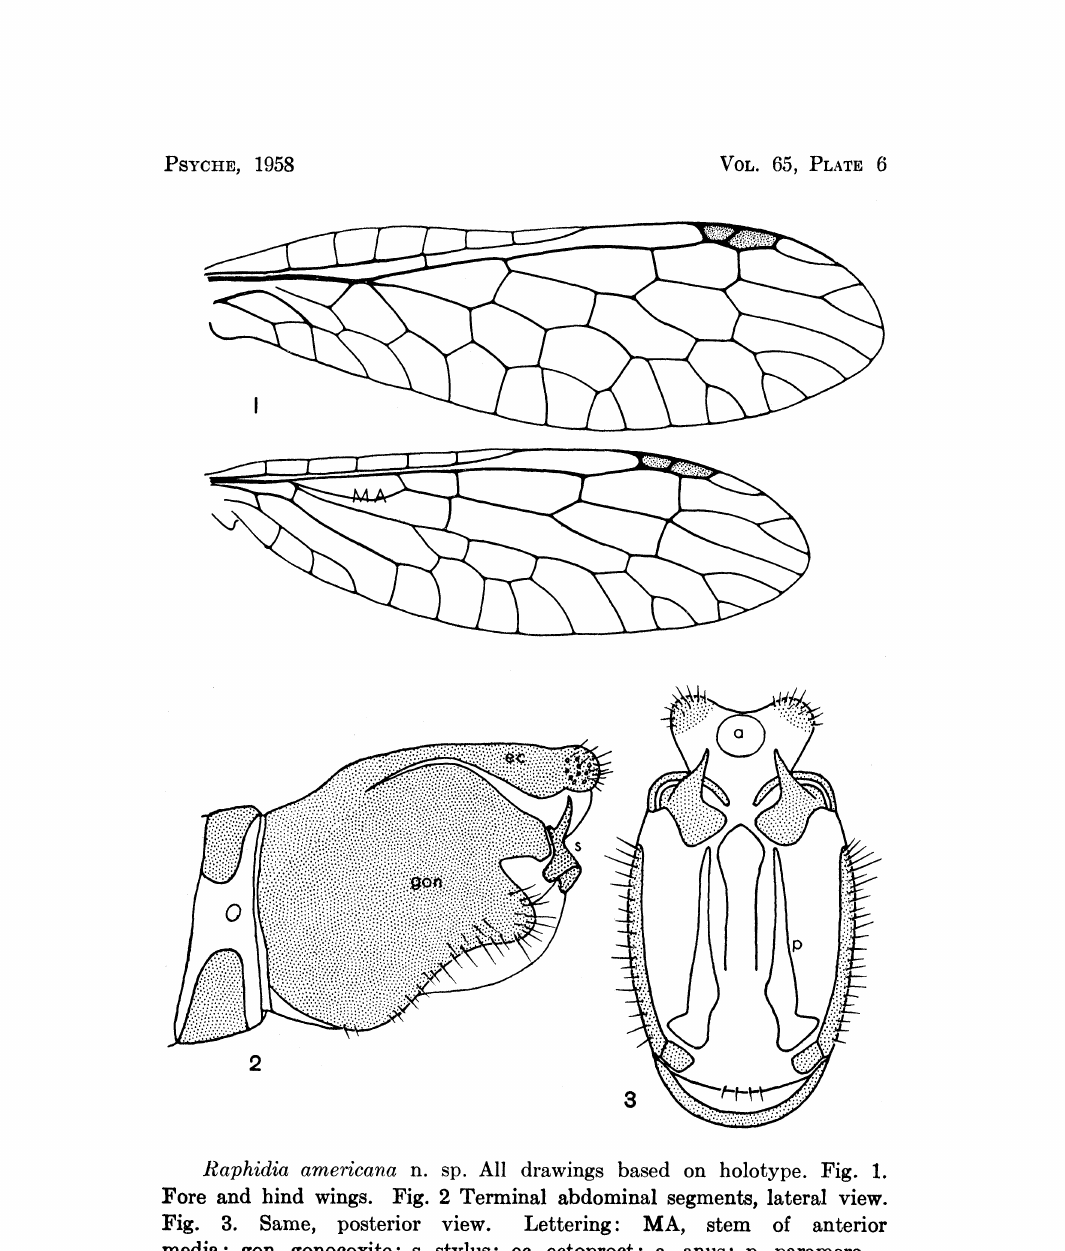
Raphidia americana n. sp. All drawings based on holotype. Fig. 1. Fore and hind wings. Fig. 2 Terminal abdominal segments, lateral view. Fig. 3. Same, posterior view. Lettering" MA, stem of anterior media; gon, gonocoxite; s, stylus; ec, ectoproct; a, anus; p,